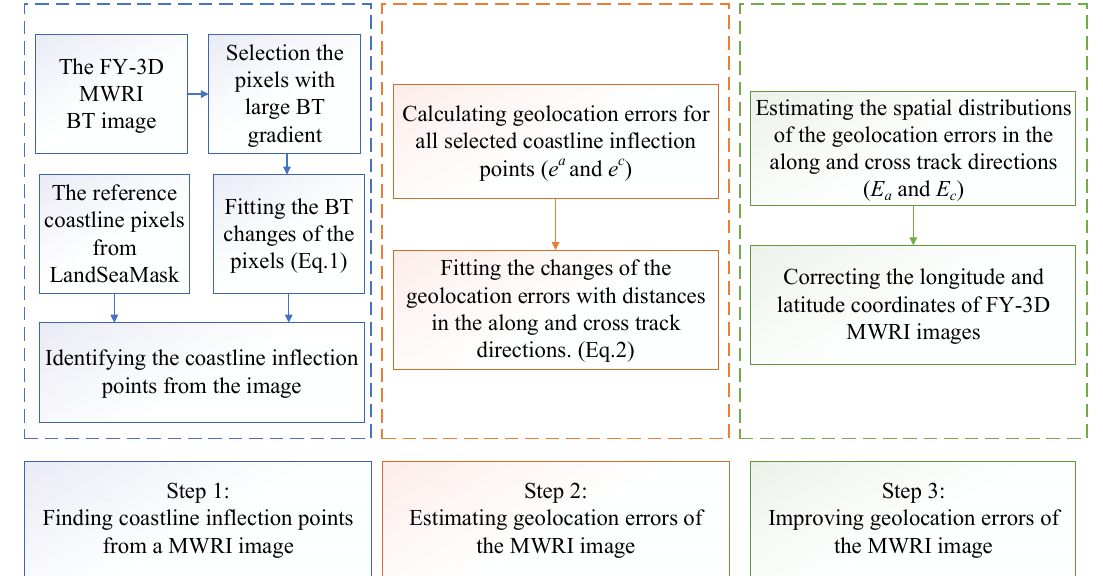
Figure 2. The flowchart of the SCIM geolocation correction for FY ‐ 3D MWRI data.